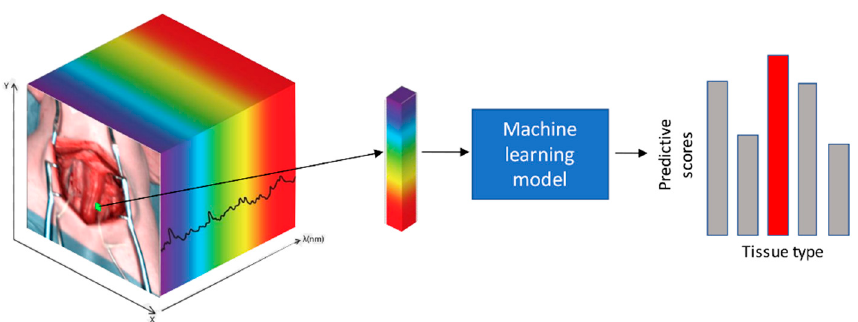
Figure 4. Schematic representation of hyperspectral (HS)-based tissue class recognition: Illustration of the general tissue recognition problem with HS image data. The core task is to recognize the tissue type at a given spatial location within an HS image. A sub-volume is extracted at the spatial location with a small spatial window, which is passed to the predictive machine learning model. Predictive scores are then automatically generated for each tissue class. Finally, the class with the highest pre- dictive score is selected.